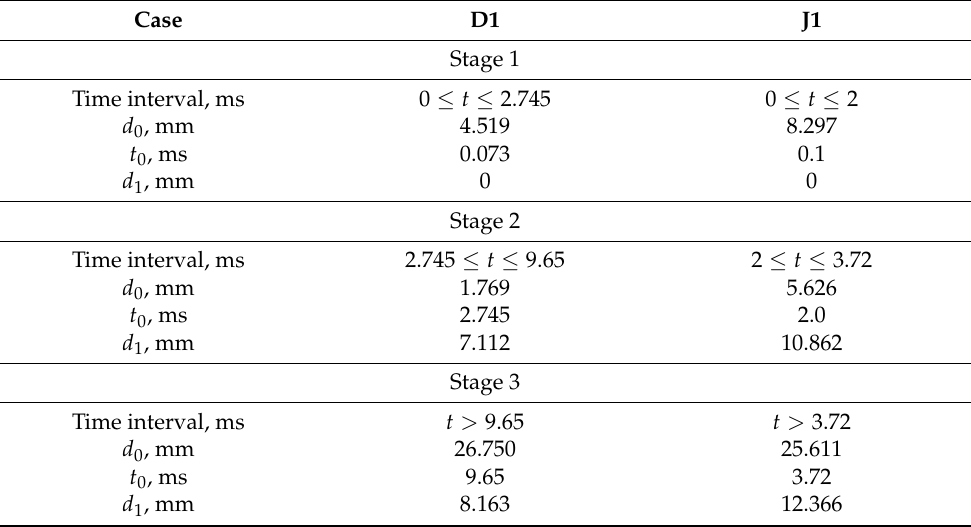
Table 4. Best-fit approximation parameters (see Equation